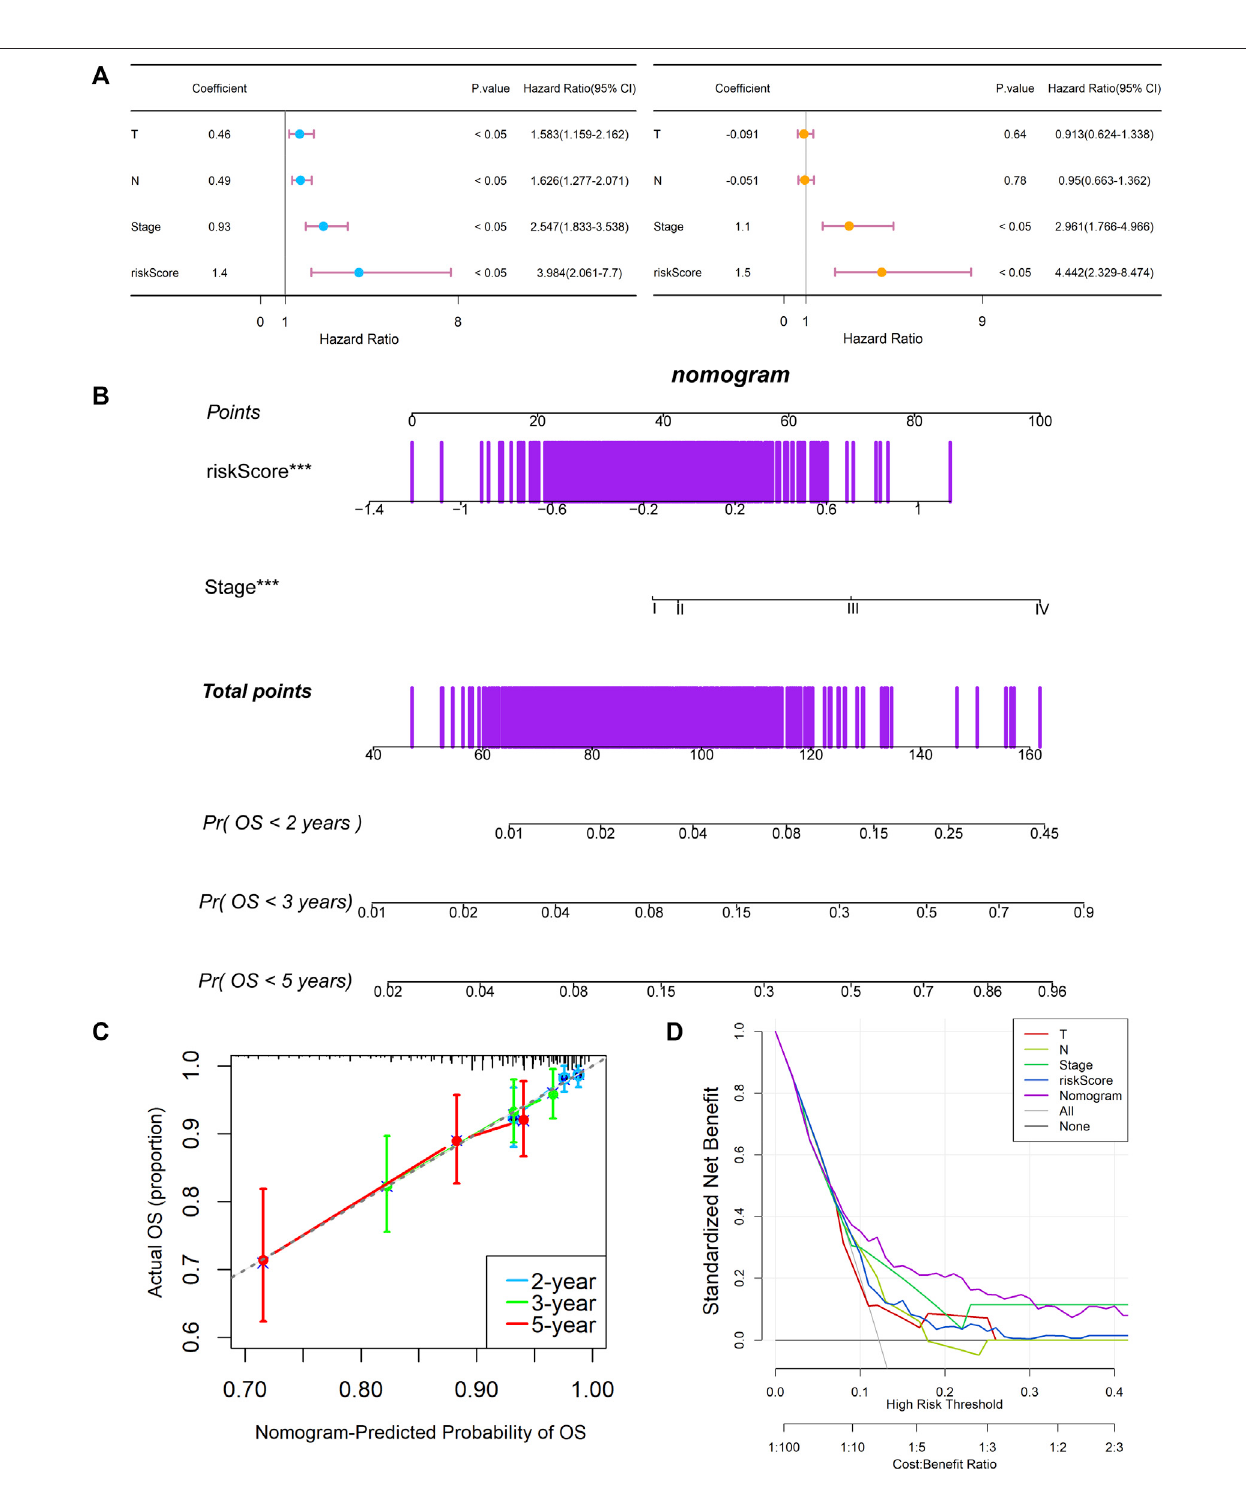
FIGURE6| EstablishmentandassessmentoftheKCNK-basednomogramsurvivalmodelforbreastcancer. (A) Univariateandmultivariateanalysisforthetraining cohort. (B) The nomogram for predicting the overall survival of the patients with breast cancer. (C) Calibration plots showed the probability of 2-, 3-, and 5-years overall survival in training cohort. (D) DCA of nomogram predicting 2-, 3-, and 5-years overall survival.